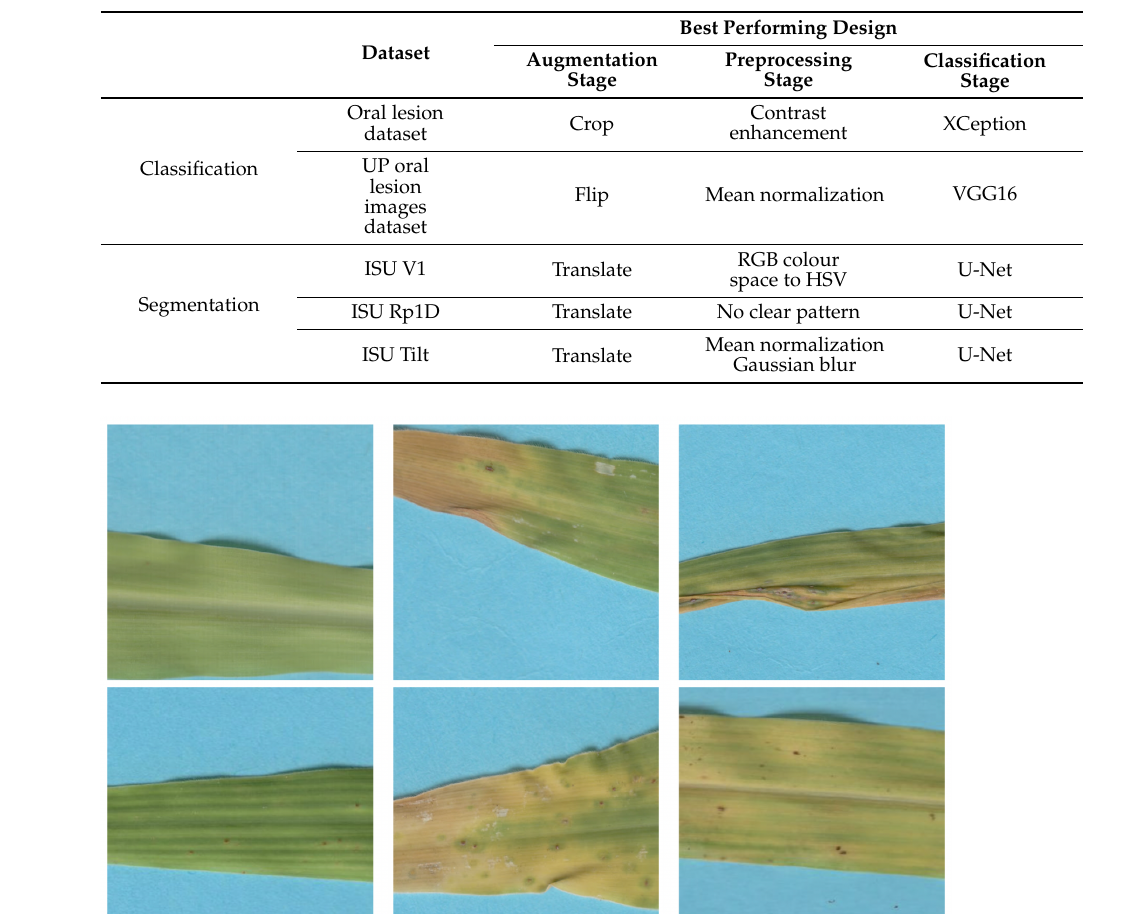
Table 18. Best-performing designs produced by the SPHH for the image processing datasets.